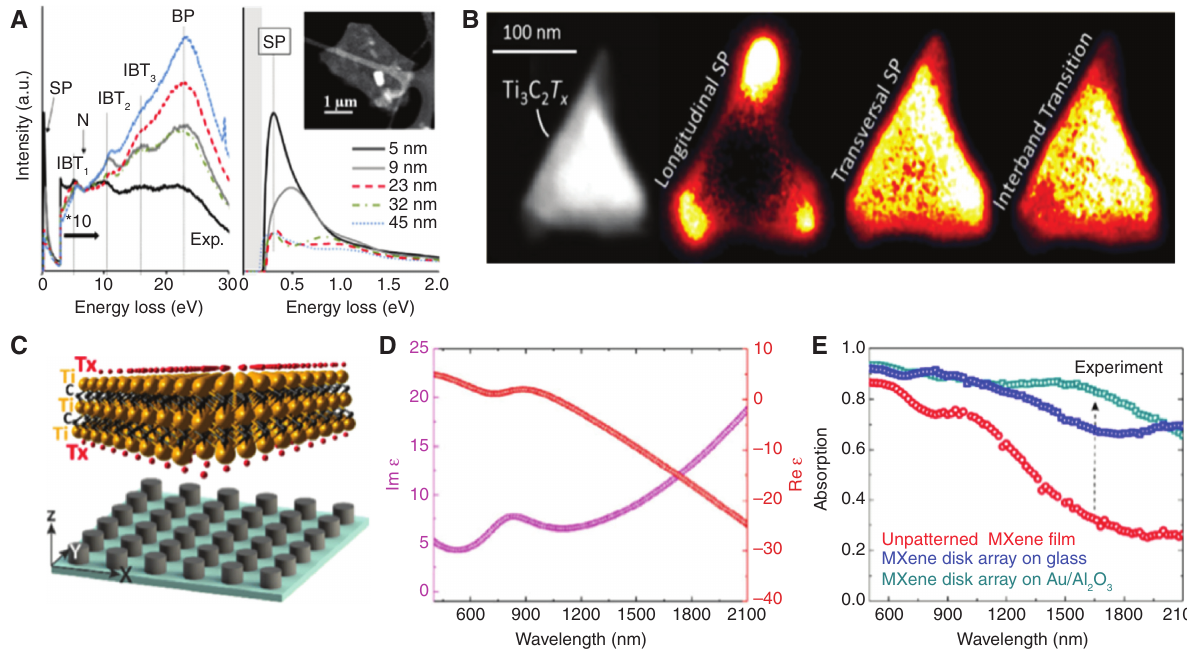
Figure 6: Demonstration of MXene surface plasmon. (A) Low-loss spectra of Ti C (OH) with different thicknesses. Intensities are magnified by an order of magnitude above 3 eV. Detailed 3 2 2 demonstration of surface plasmon (right). (B) STEM-HAADF images of a triangular Ti of SP and interband transition. (C) Schematic of Ti C T nanodisk array. (D) Experimentally measured real and imaginary parts of permittivity 3 2 x (ε) of Ti C T film with 400-nm thickness. (E) Experimentally measured absorption spectra of unpatterned Ti 3 2 x nanodisk arrays. (A) Reproduced with permission [70]. Copyright 2014, American Physical Society. (B) Reproduced with permission